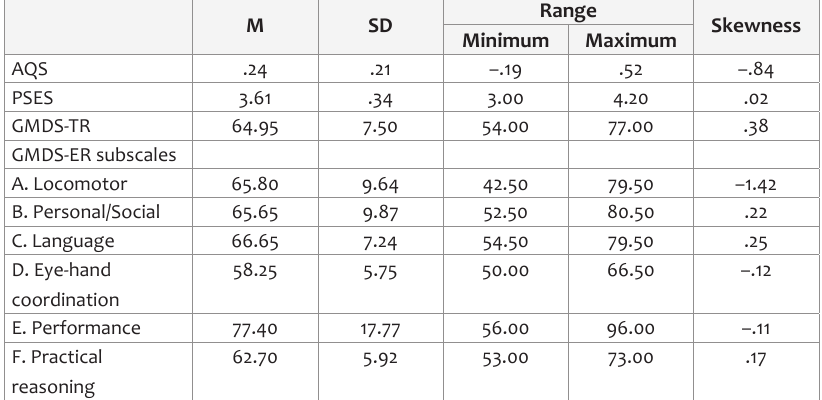
Table 1: Descriptive Statistics (n = 10) for the AQS, PSES, GMDS-TR with 6 subscales Range M SD Skewness Minimum Maximum AQS